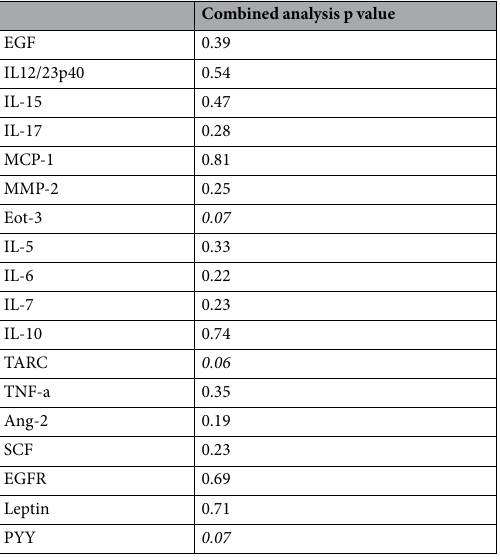
Table 4. Combined analysis of the biomarkers with longitudinal assessment between HC and